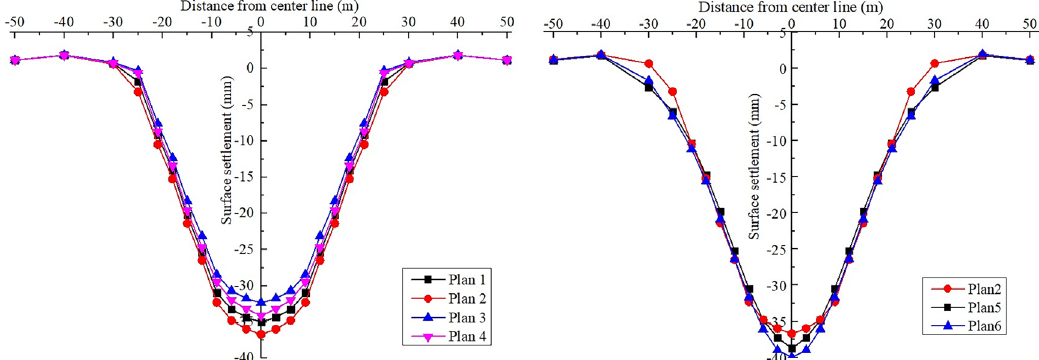
Figure 18. Comparison of surface settlements of different schemes.